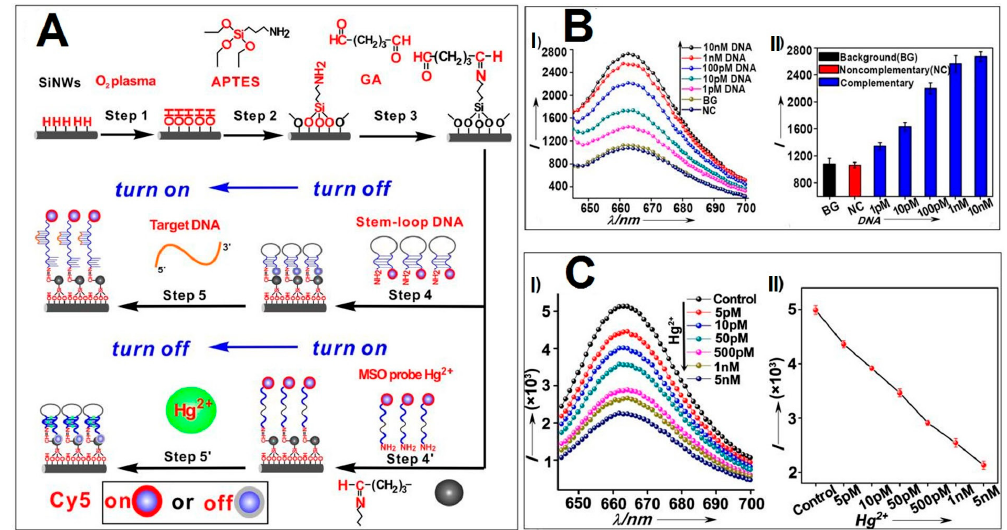
Figure 8. ( A ) Schematic diagram of construction of SiNW-based fluorescent sensor for DNA and Hg 2+ detection. ( B ): ( I ) Fluorescence spectra and ( II ) corresponding PL intensities of complementary target DNA with serial concentrations. ( C ): ( I ) Fluorescence spectra and ( II ) corresponding calibration curve of SiNW-based sensors for detection of Hg 2+ with serial concentrations. Reproduced with permission from [24]. Copyright 2014, RSC.